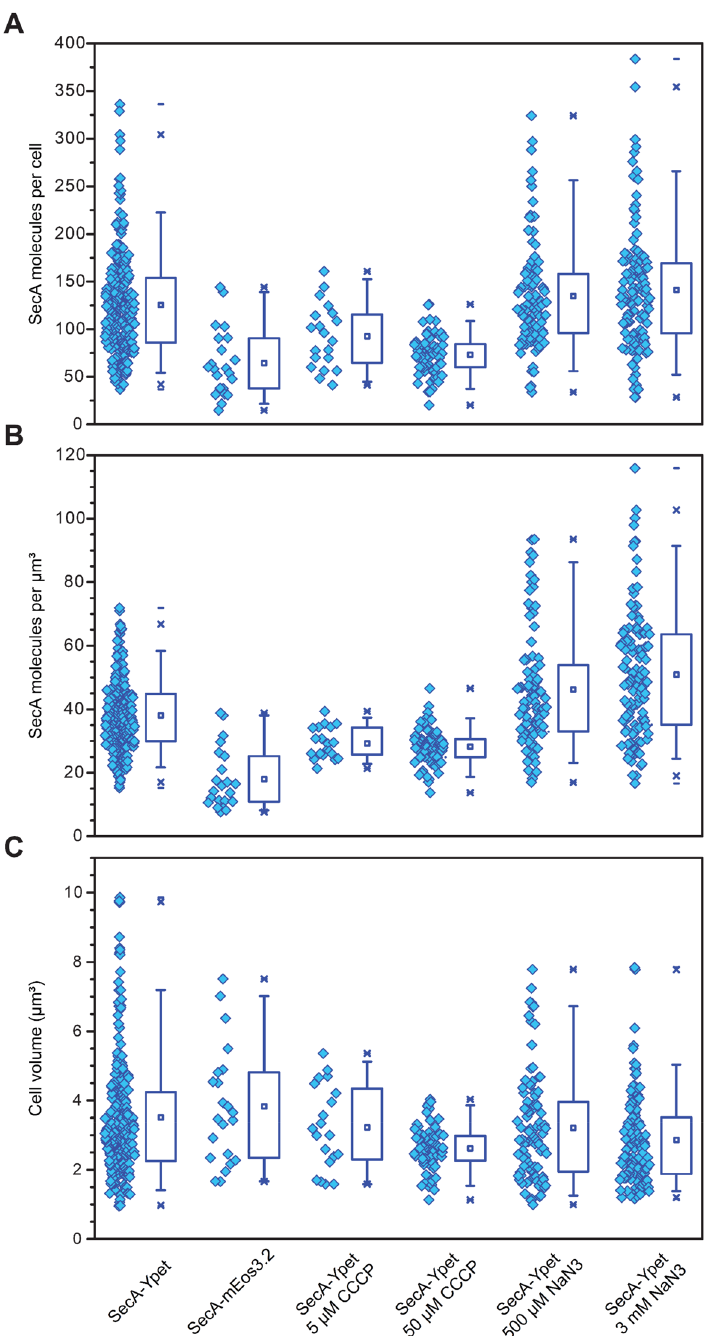
Figure 3. Cellular SecA copy numbers under different conditions. Plotted per condition are the values for each individual cell (left, open diamond) and corresponding boxplot (right) showing the lower 25% and upper 75% quartile with mean indicated by (open square). ( A ) SecA molecules calculated per cell. ( B ) SecA molecules per cubic micrometer or femtoliter, and estimated cell volumes ( C ). Whiskers indicate the lower 5% and upper 95%